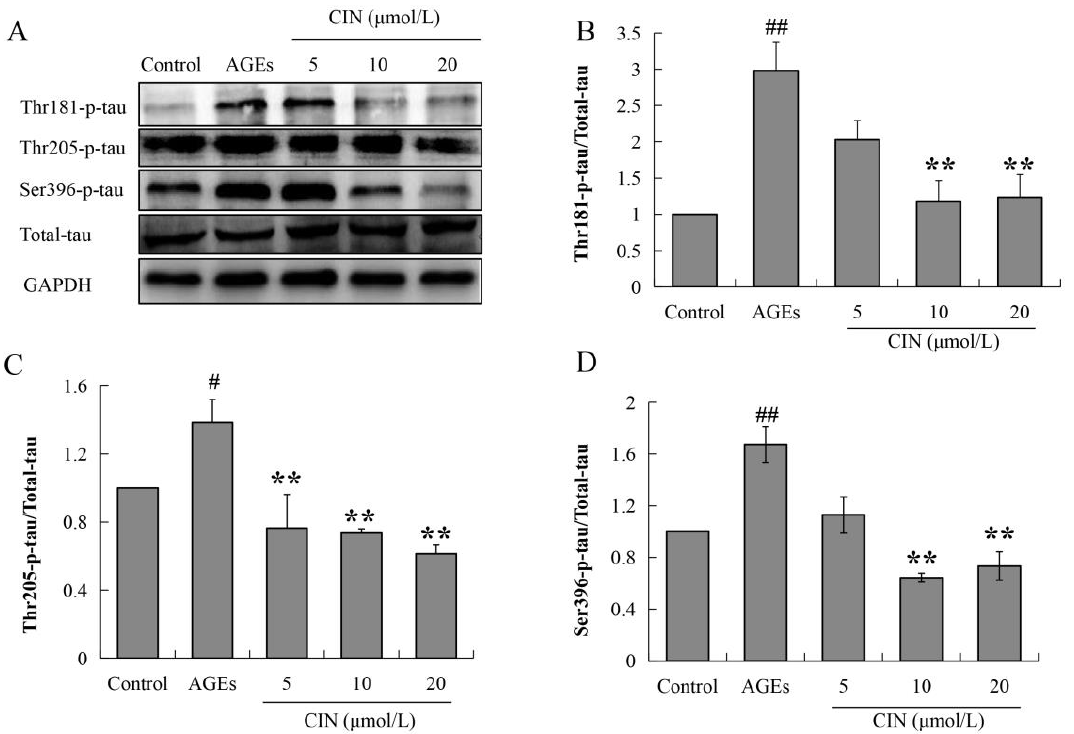
Figure 3. Effects of CIN on the tau hyperphosphorylation in vitro. ( A – D ) The protein levels of phosphorylated tau at thr181, thr205 and Ser396 sites in SH-SY5Y cells were detected by Western blot. n = 3. # p < 0.05, ## p < 0.01 compared with the control group; ** p < 0.01 compared with the model group.